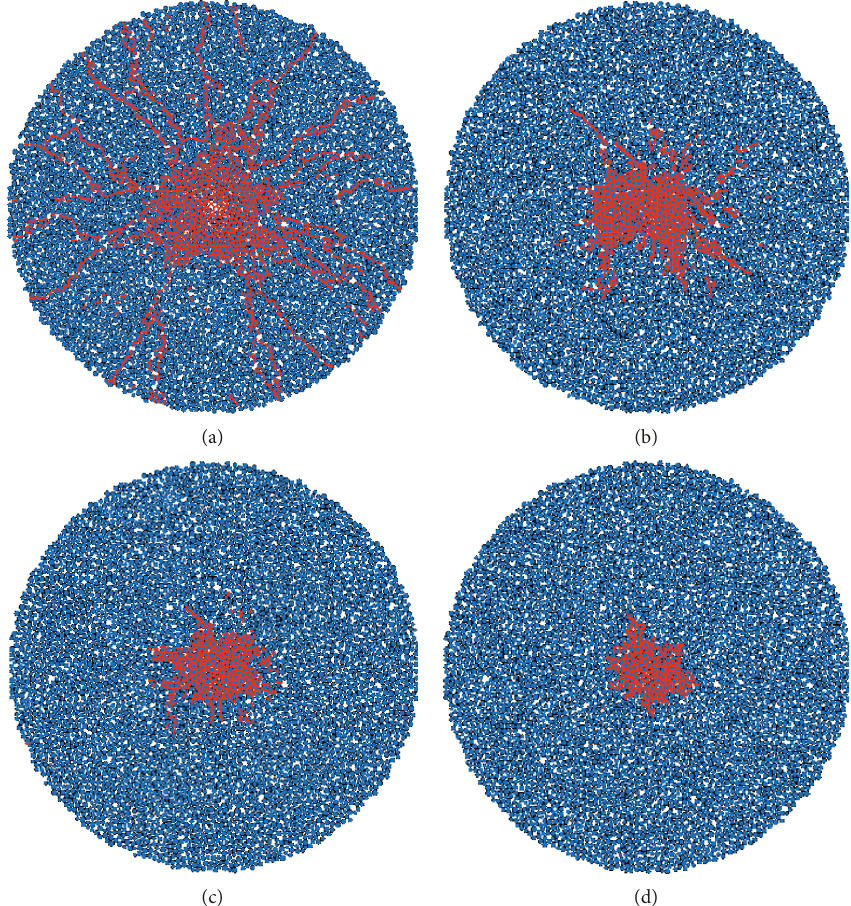
Figure 9: Breakingstateofanelectropulseat100 μ